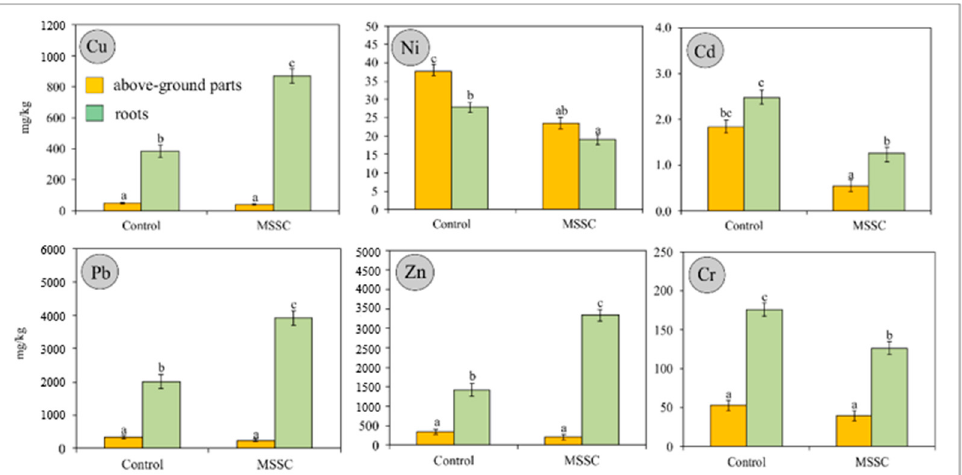
Figure 2. Contents of Cu, Ni, Cd, Pb, Zn, and Cr in the above-ground parts and the roots of Dactylis glomerata L. (n = 3, mean ± standard deviation). For a given HM, different letters indicate significant differences in its accumulation in above-ground parts or in the roots of Dactylis glomerata L.